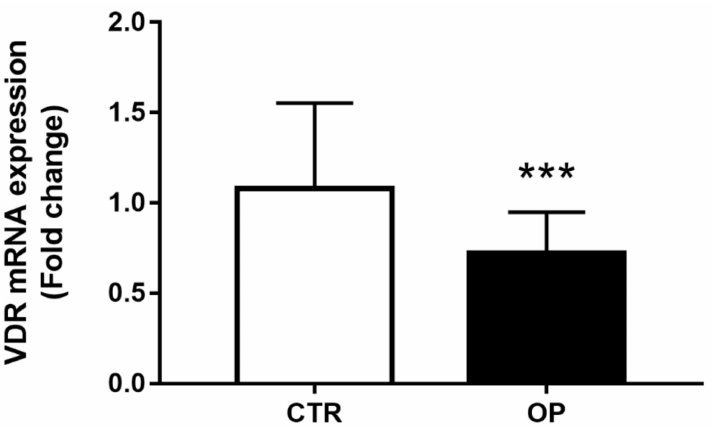
Figure 1. PBMC expression level of VDR in OP patients (n = 25) and CTR (n = 25). GAPDH mRNA level was used to normalize the amount of VDR and expression values are expressed as 2 − ∆∆ Ct . Statistical differences between OP and CTR groups were analyzed by a non-parametric Mann–Whitney U -test (*** p = 0.0009).